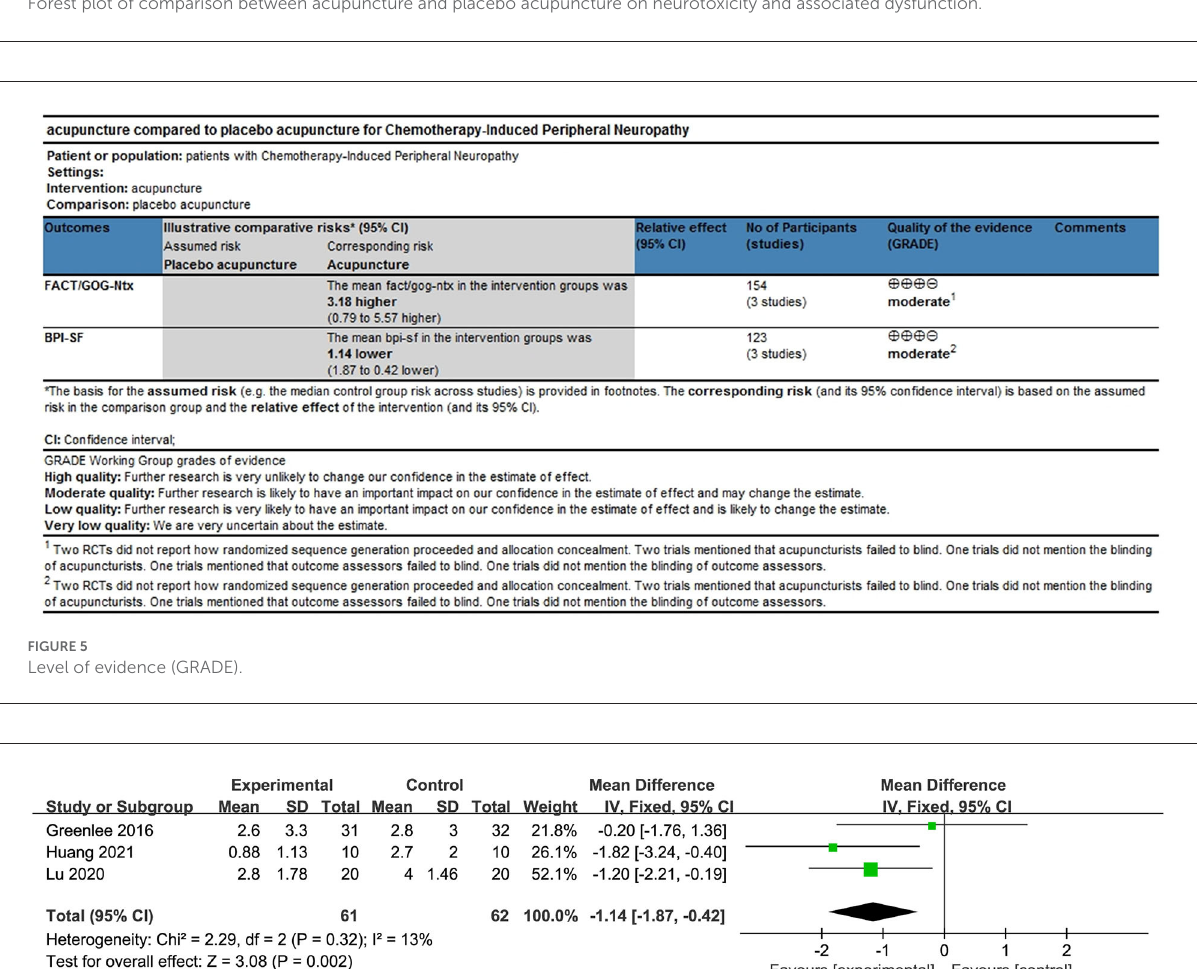
Comparison with other studies